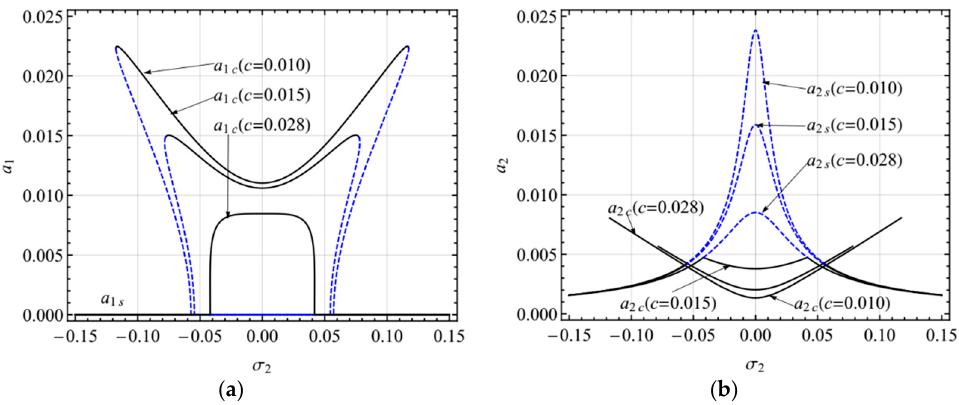
Figure 8. Frequency-response curves of the primary resonance of the second mode for c = 0.010, 0.015, 0.028; ( a ) the first mode, ( b ) the second mode.